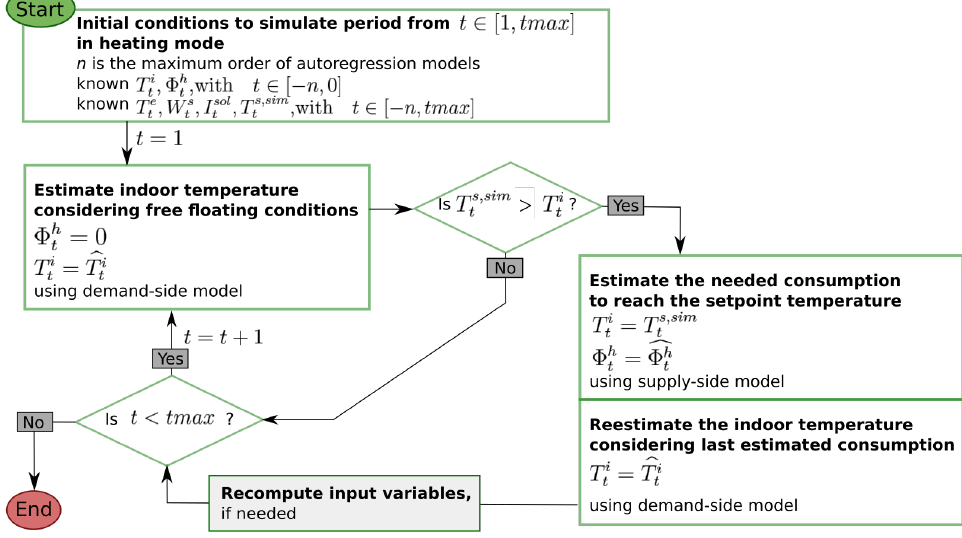
Figure 3. Models coupling flow